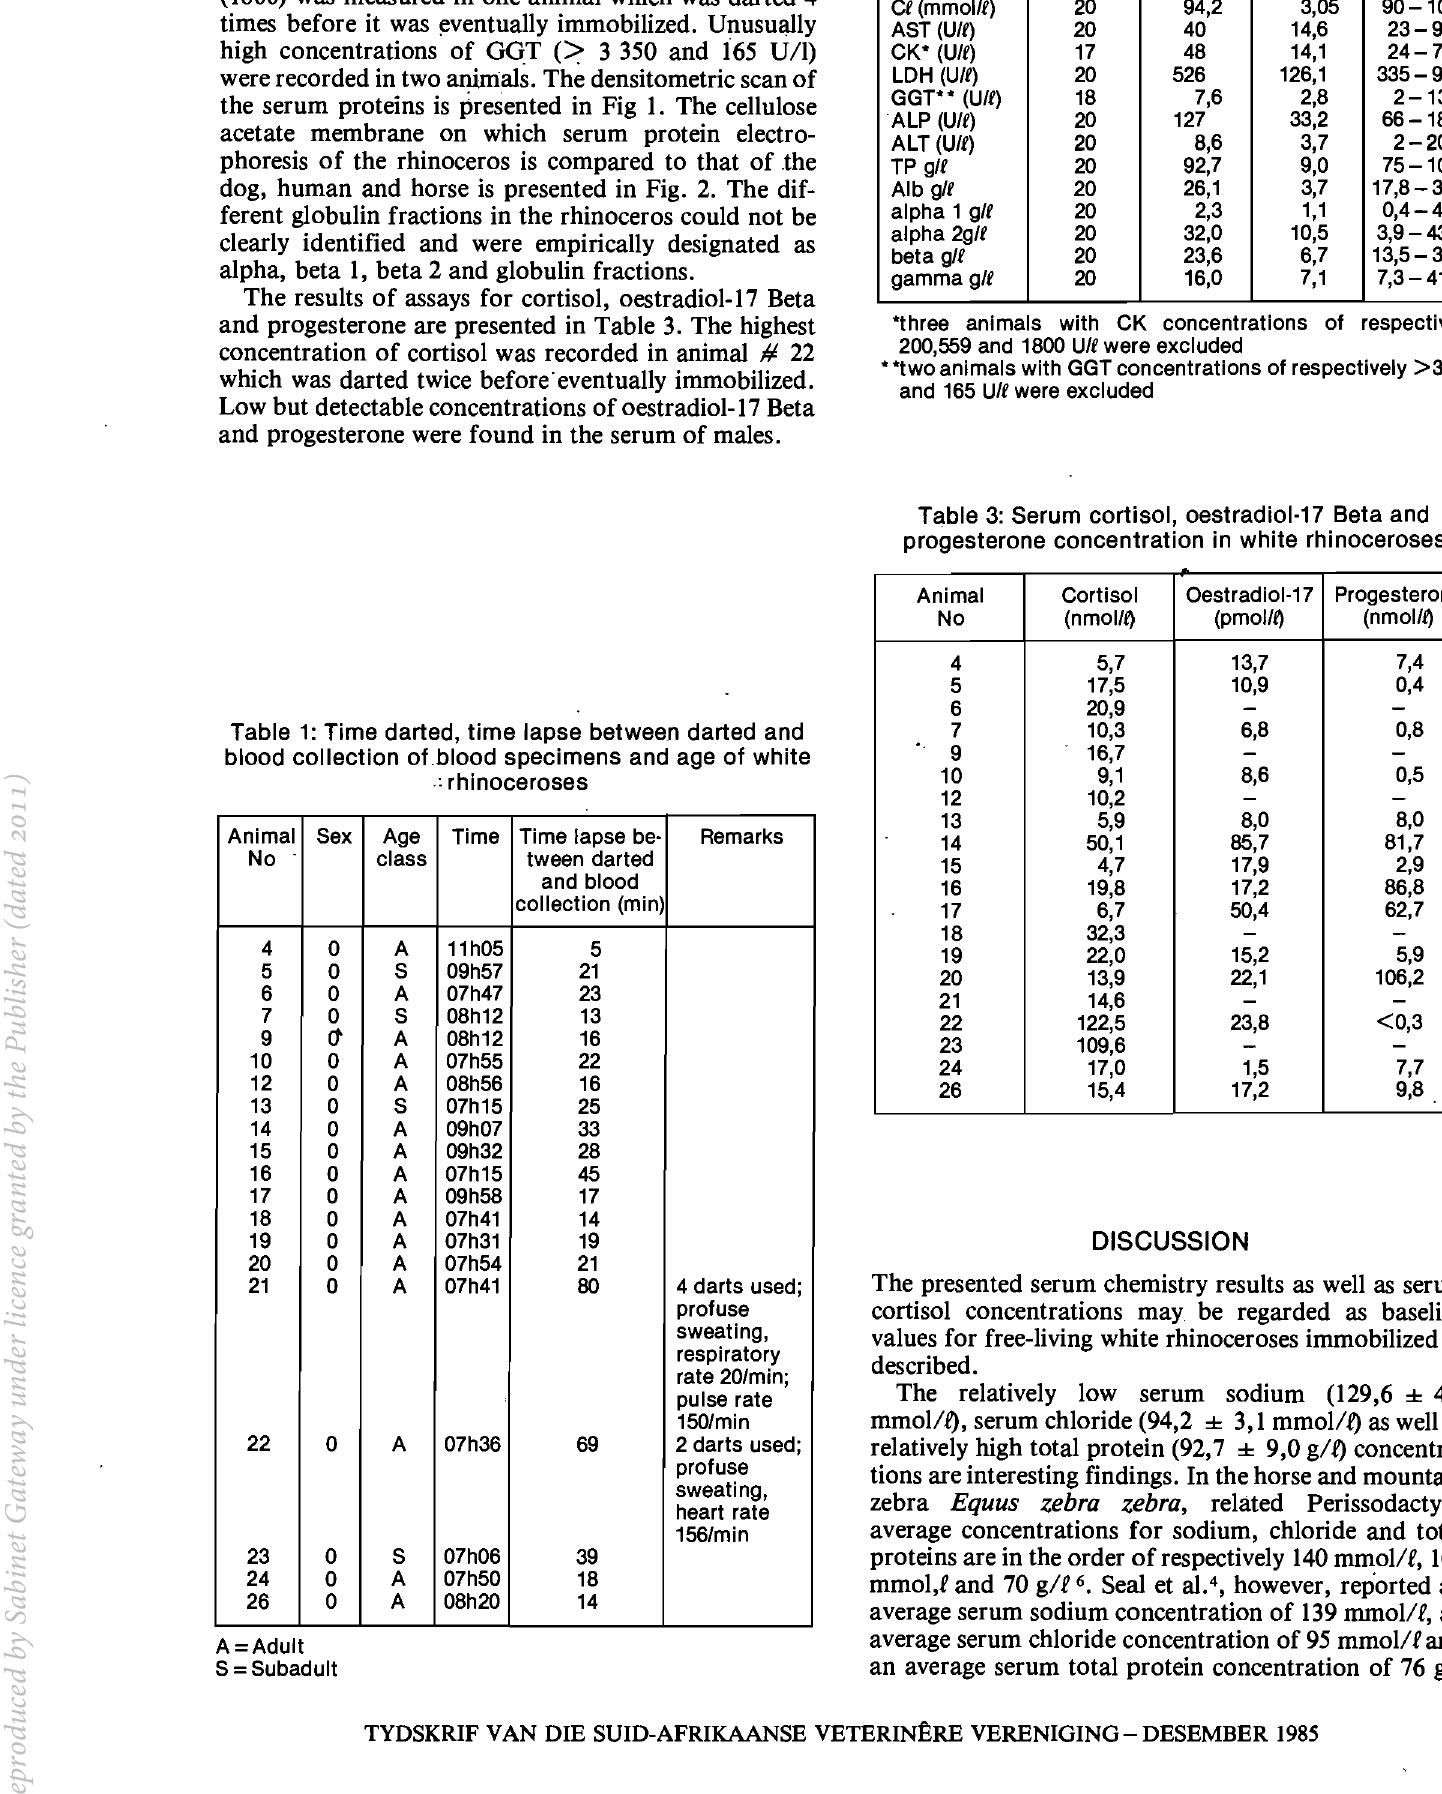
Table 2: Concentrations of serum chemical constituents in white rhinoceroses n x SO